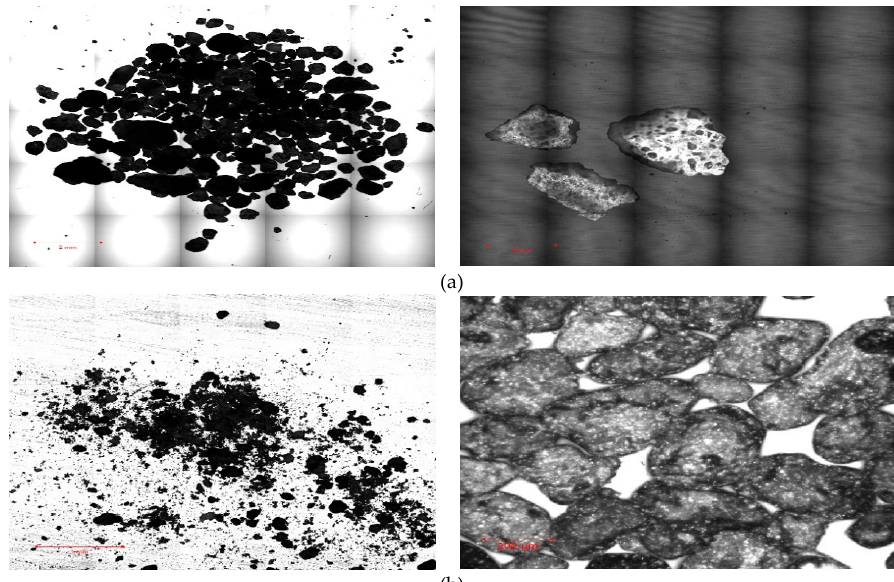
Figure 6. Laser scanning microscope images of the waste sand. ( a ) Coarse portion with particle size greater than 0.425 mm. ( b ) Fine portion with particle size smaller than 0.425 mm.